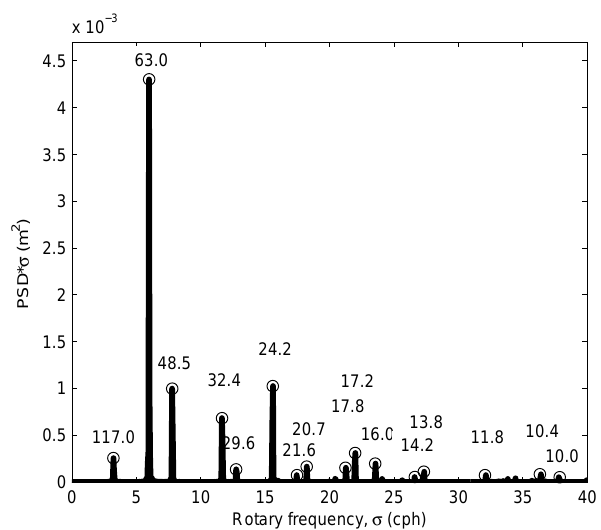
Figure 2. The synthetic maximum spectrum of modeled lake sur- face oscillations. Significant peaks are marked with circles with cor- responding seiche periods in